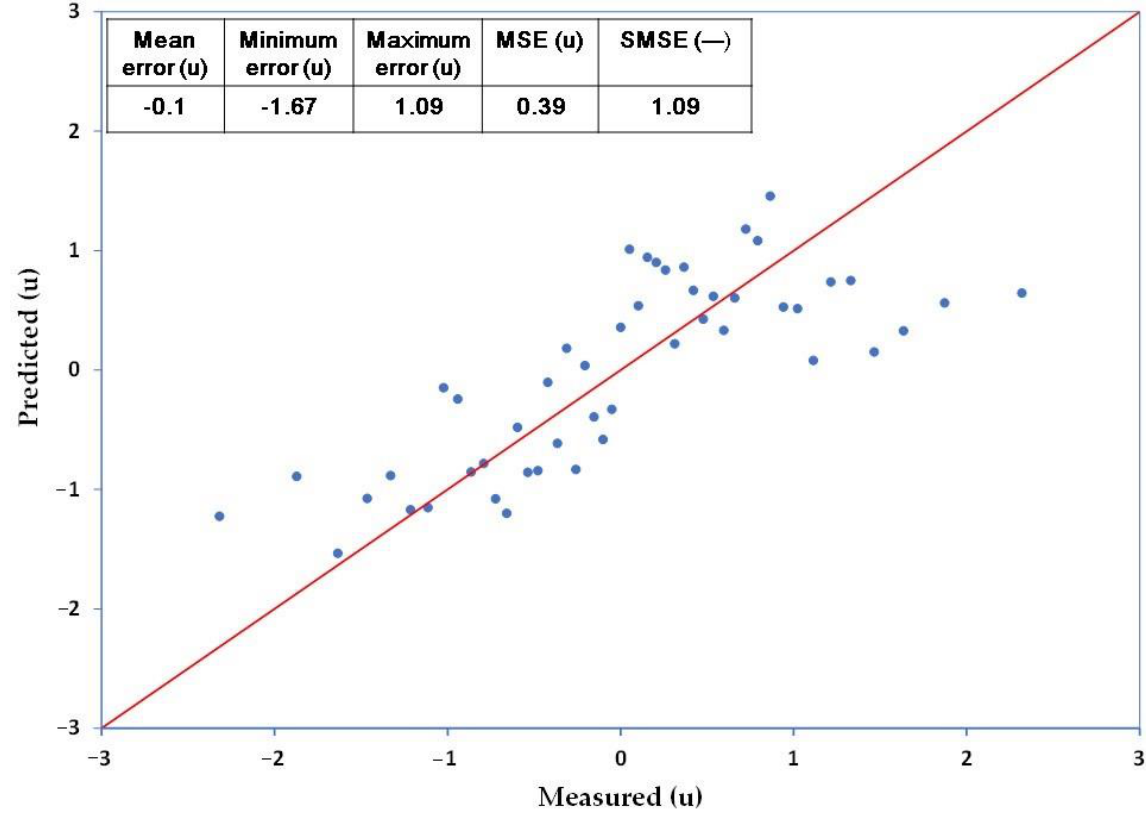
Figure 5. Cross-validation results.